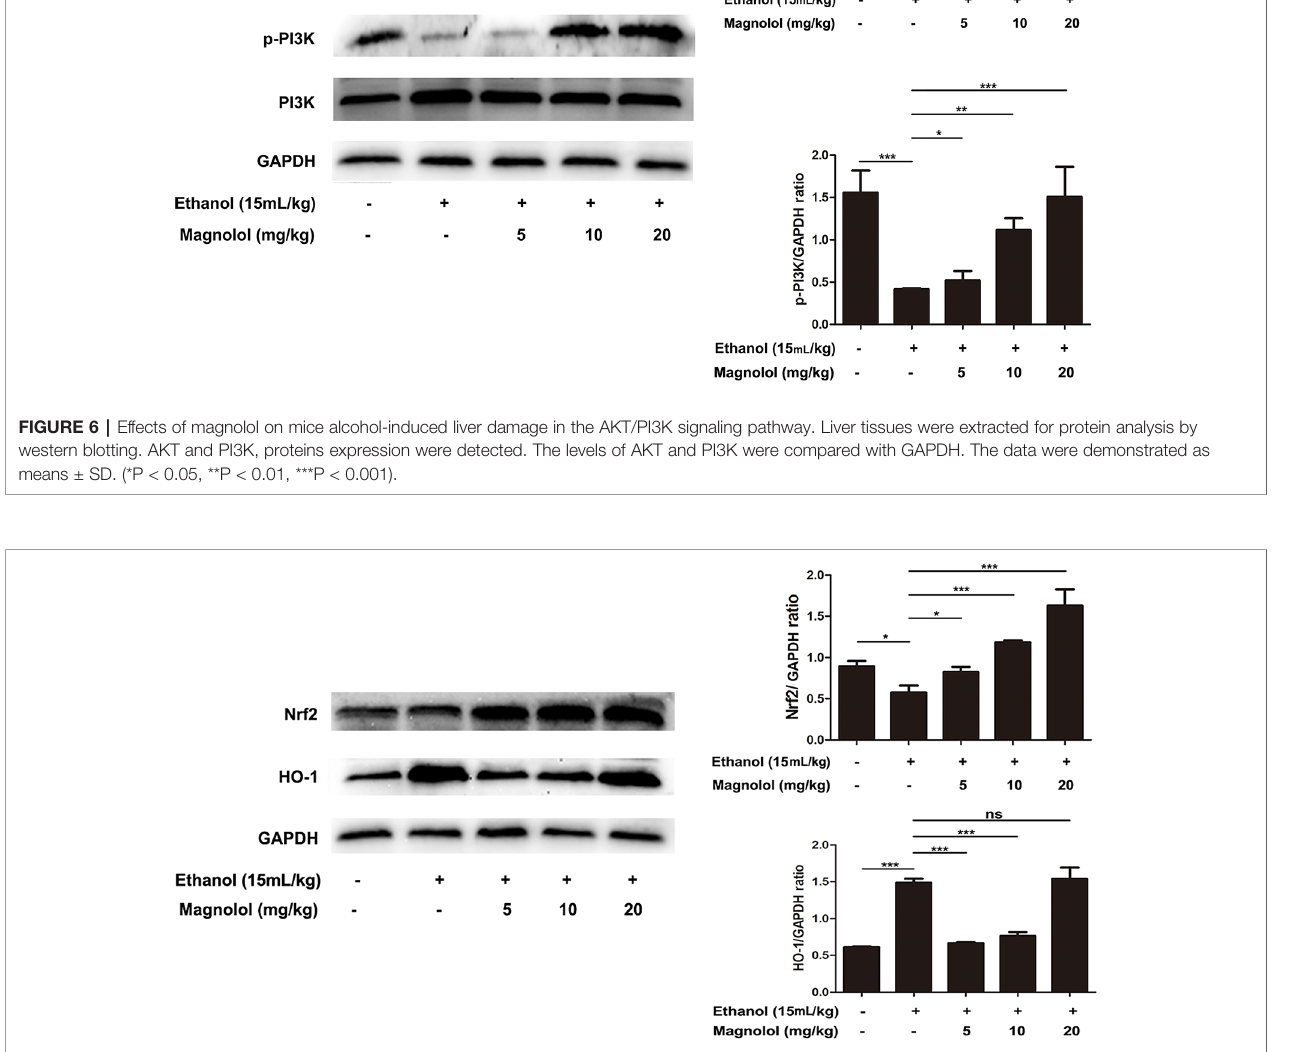
FIGURE 7 | Effects of magnolol on mice alcohol-induced liver damage in the Nrf2/HO-1 signaling pathway. After the completion of modeling and samples were collected, the liver of mice was lysed to detect the proteins by western blotting analysis. The levels of Nrf2 and HO-1 were compared with GAPDH. The data were demonstrated as means ± SD. (*P < 0.05, ***P < 0.001 and "ns" means not signi fi